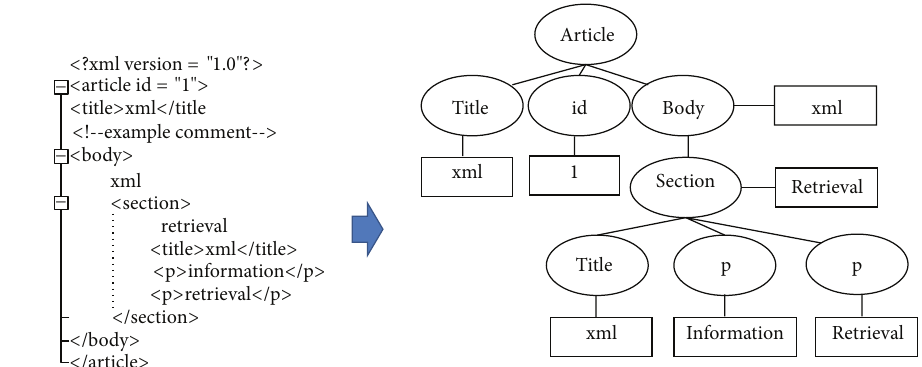
Figure 1: The Example of XML Element Tree.